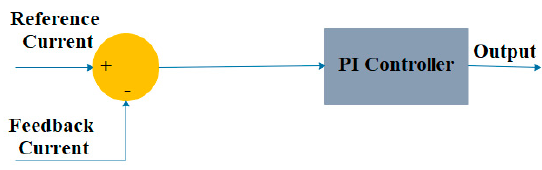
Figure 30. Current controller using PI.